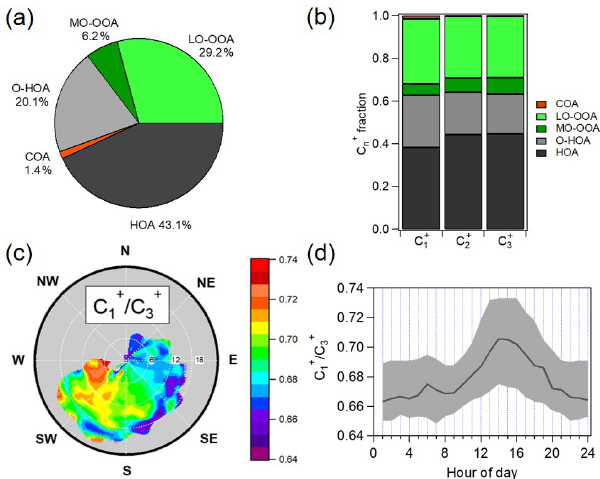
Figure 4. (a) Fractions of rBC and (b) the relative contributions of C + –C + fragments contributed by the five OA components identi- 1 3 fied by the PMF analysis with OA and rBC fragments measured by the laser-on mode as model inputs. (c) NWR plot and (d) diurnal / C + cycle of the C + ratio (the 25th and 75th percentiles are shown 1 3 using the shaded